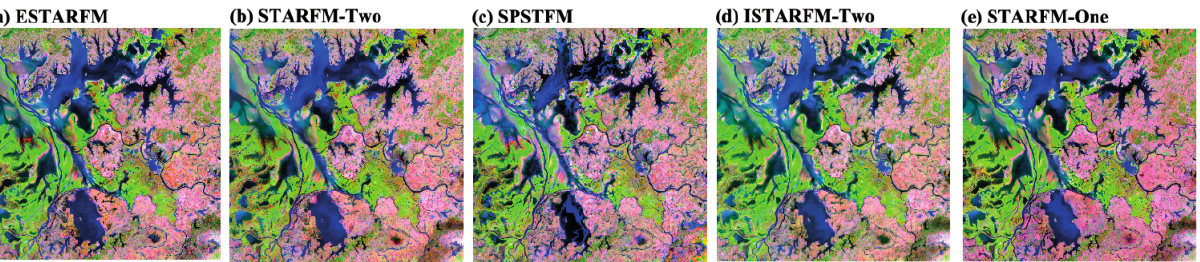
Figure 5. Predicted Landsat-like images and the observed Landsat ETM+ image for the CIA site on 12 January 2002. ( a – d ) Blended images under the two L-M pairs prediction mode using ESTARFM, STARFM-Two, SPSTFM, and ISTARFM-Two, respectively; ( e , f ) Blended images under the one L-M pair prediction mode using STARFM-One and ISTARFM-One; ( g ) Observed ETM+ image; The NDVI difference images ( h ) between the prior (T1) and predicted (T2) date, and ( i ) between the predicted (T2) and posterior (T3) dates, respectively, in which darker regions represent smaller changes and lighter regions denote larger changes. ( j )The NDVI difference contrast of (h) and